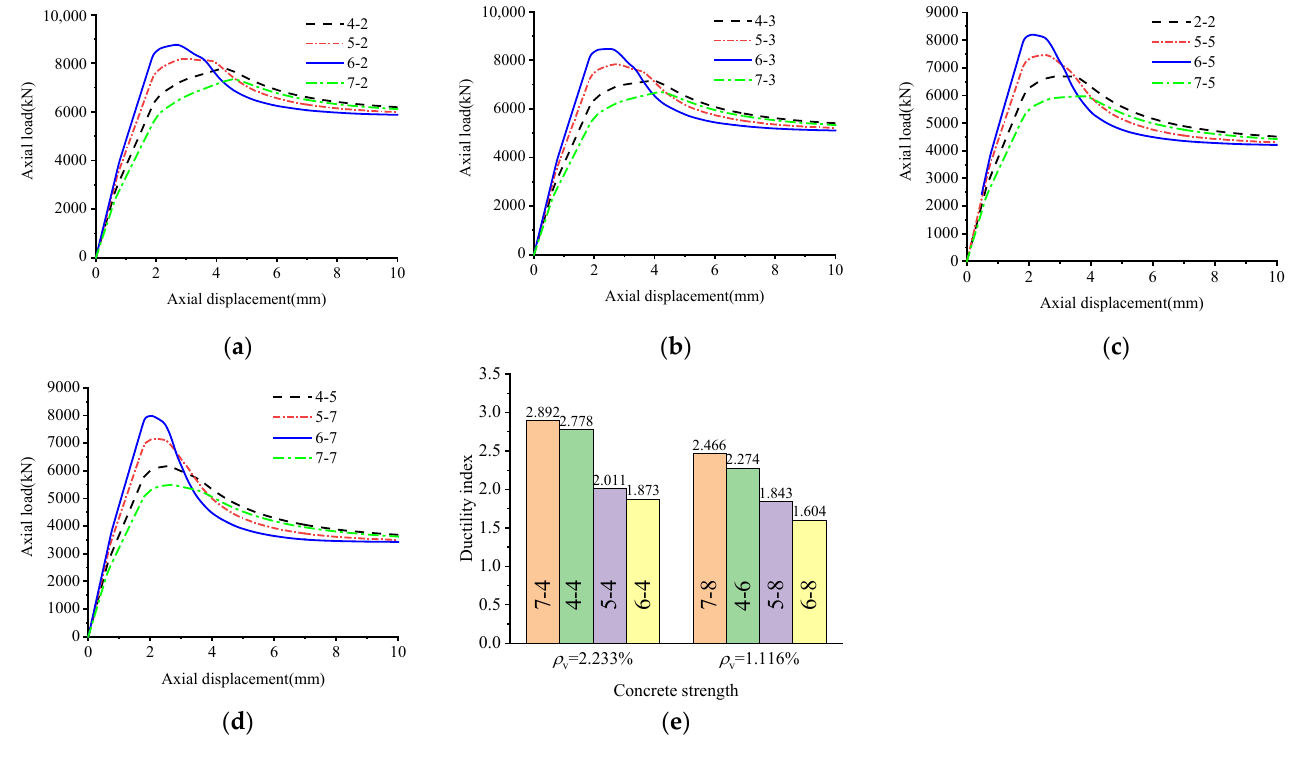
Figure 10. Effect of concrete strength: ( a ) ρ v = 3.349%; ( b ) ρ v = 2.679%; ( c ) ρ v = 1.914%; ( d ) ρ v = 1.340%; ( e ) ductility index.